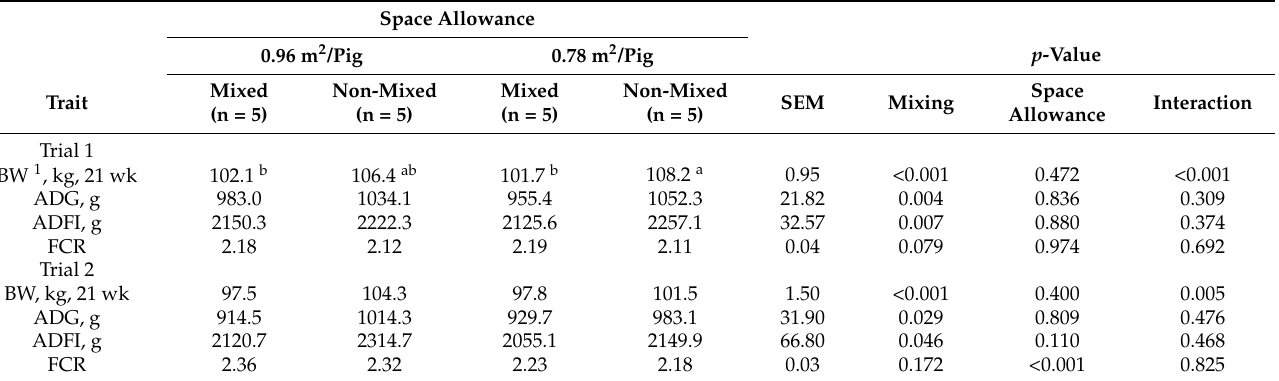
Table 3. Effect of space allowance and mixing on bodyweight (BW), average daily gain (ADG), average daily feed intake (ADFI) and feed conversion ratio (FCR) (Least square means (LS means) ± Standard error mean (SEM)) in trial 1 and trial 2 from 11 to 21 weeks of age.